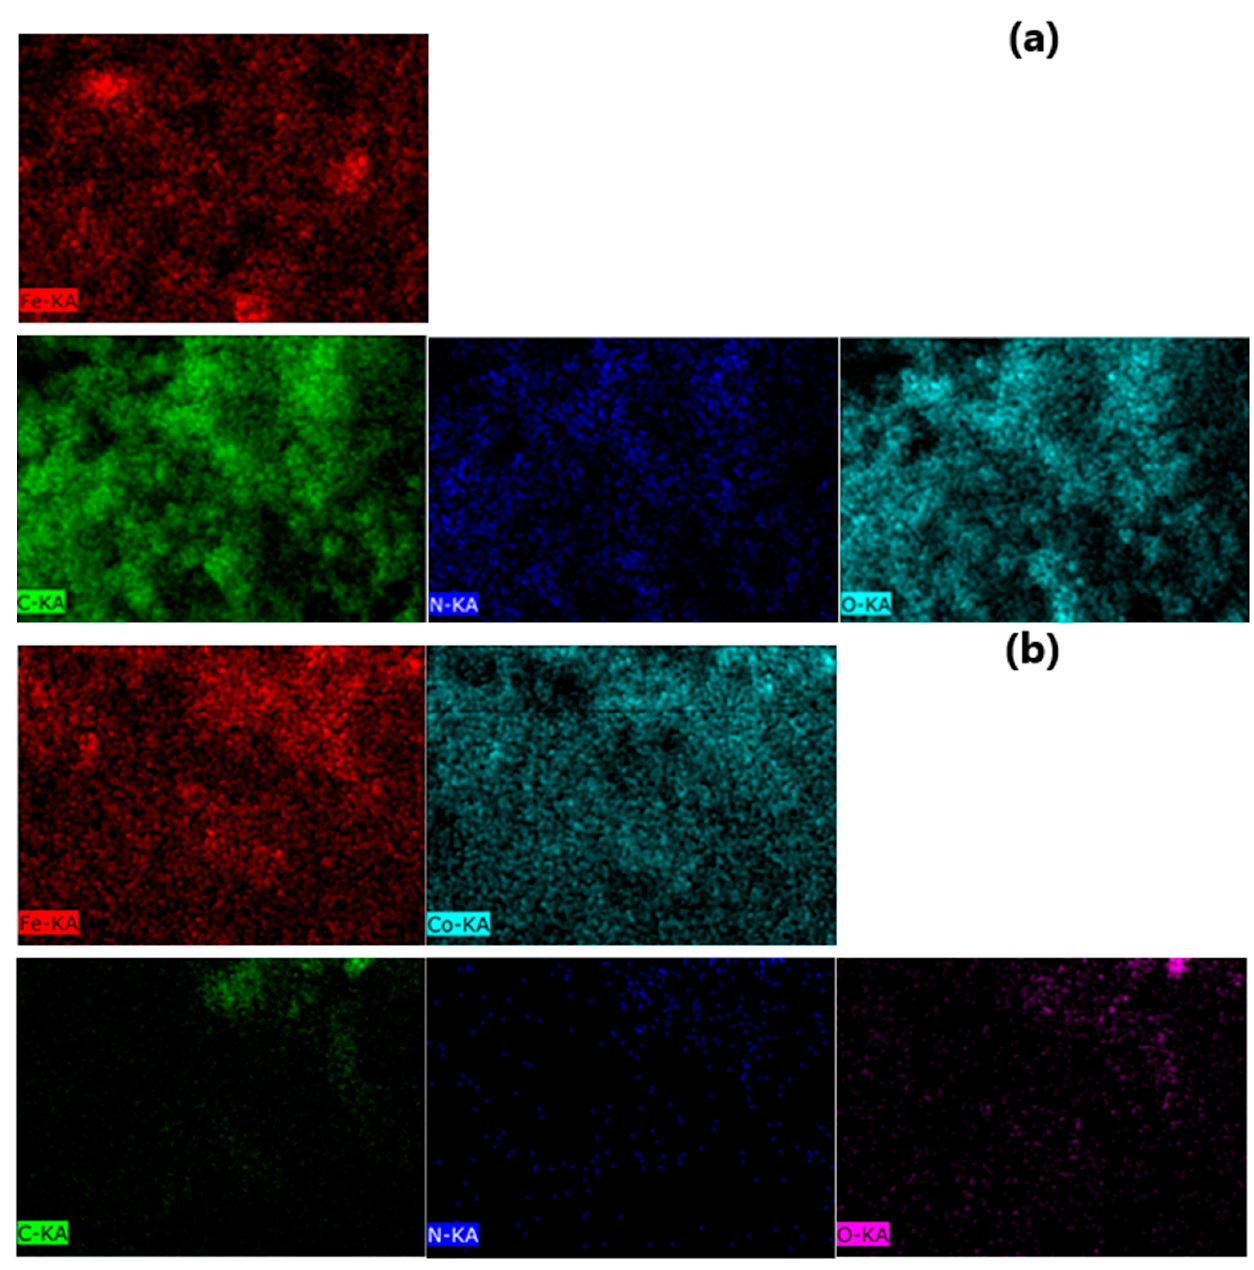
Figure 11 . SEM ‐ EDS mapping images of ferrum Fe, cobalt Co, carbon C, nitrogen N and oxygen O Figure 11. SEM-EDS mapping images of ferrum Fe, cobalt Co, carbon C, nitrogen N and oxygen O in Table 4. EDS analysis data of nanomaterials. Table 4. EDS analysis data of